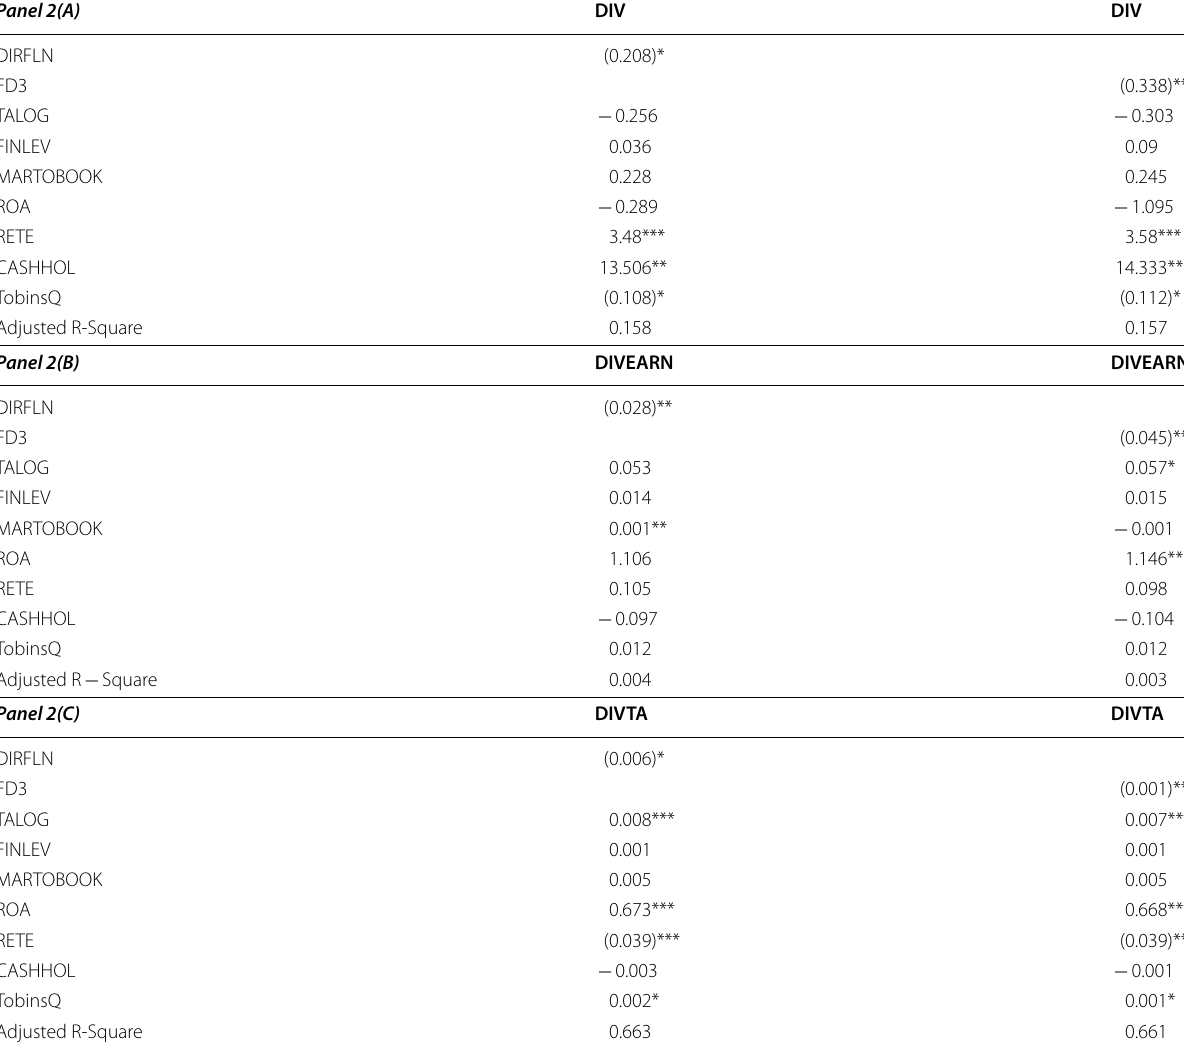
***, **, *Significance at 1%, 5% and